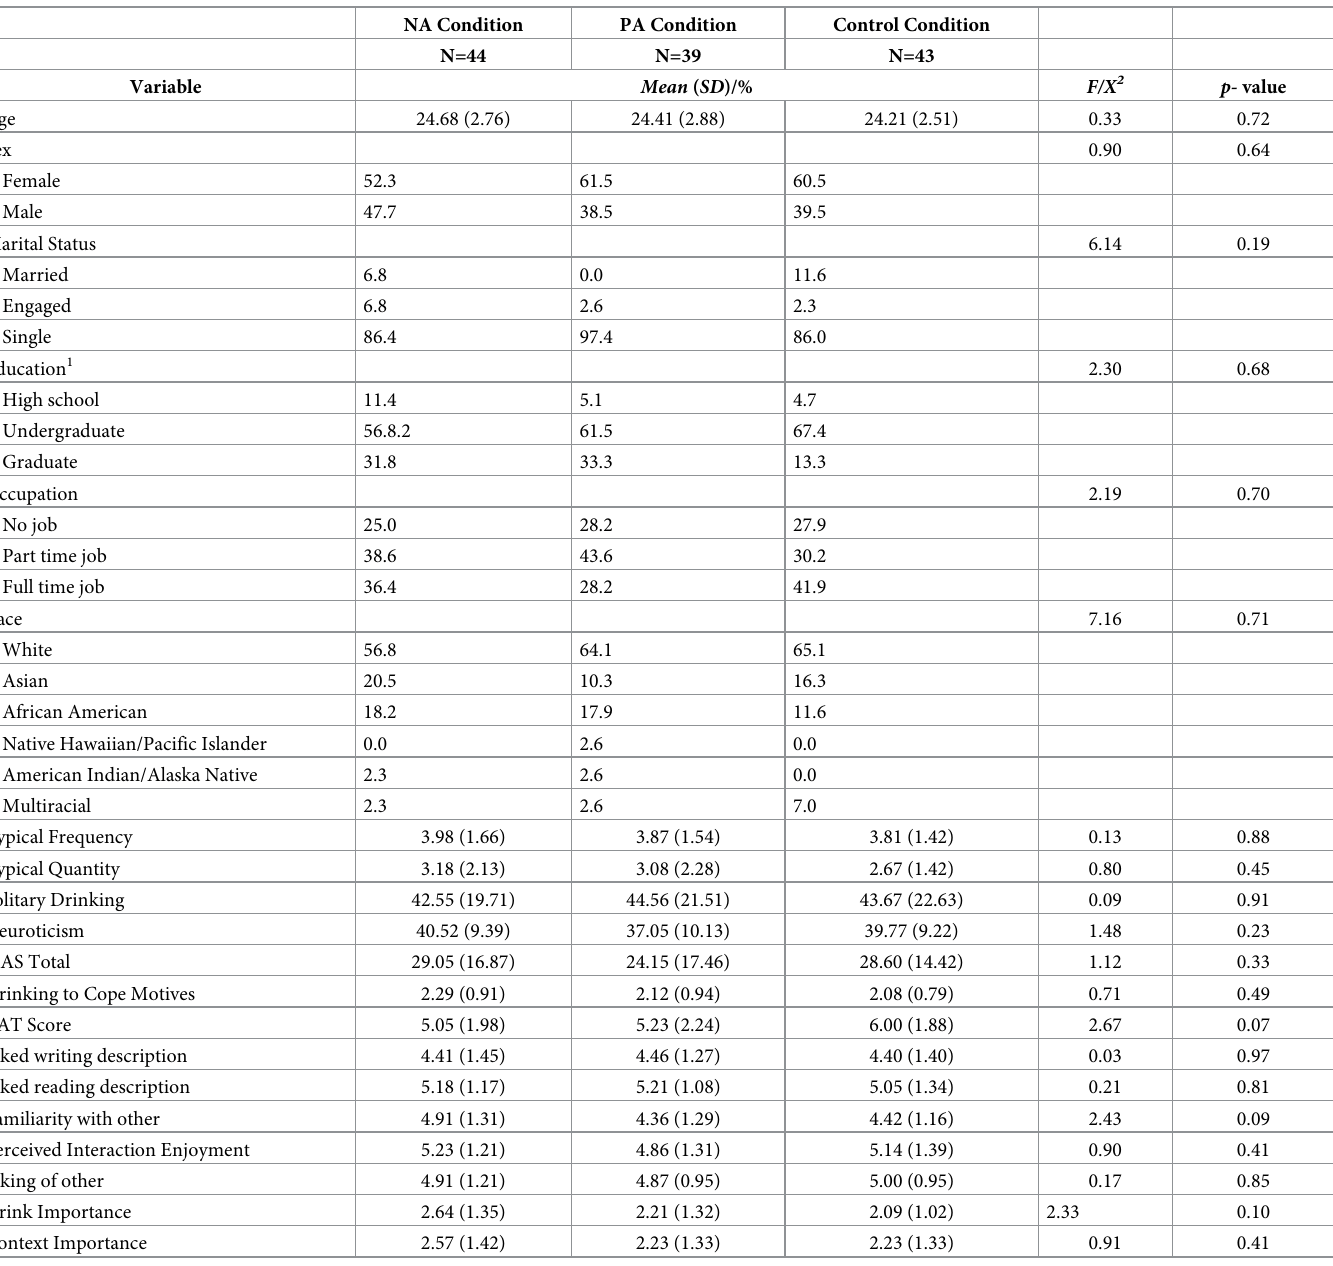
Table 1. Descriptive statistics for variables across